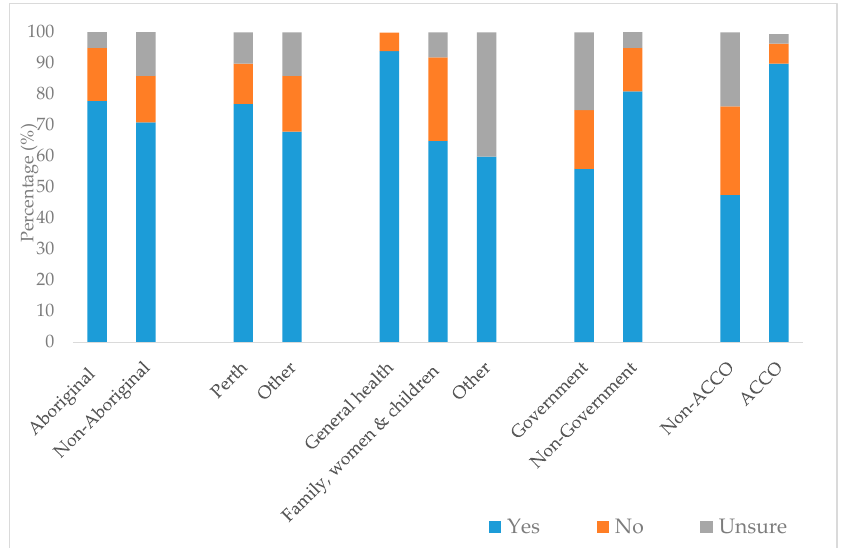
Figure 1. Perceptions of cultural security, by respondent and service-level characteristicsThe